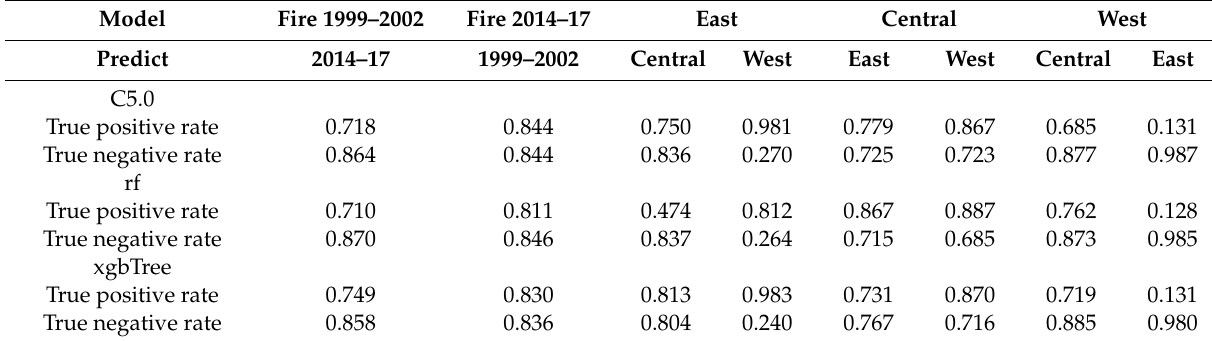
Table 4. True positive rate and true negative rate of predictions for three di ff erent classifiers (C5.0; rf = random forests, xgbTree = extreme gradient boosting with trees) of modeled training data for di ff erent years and regions.